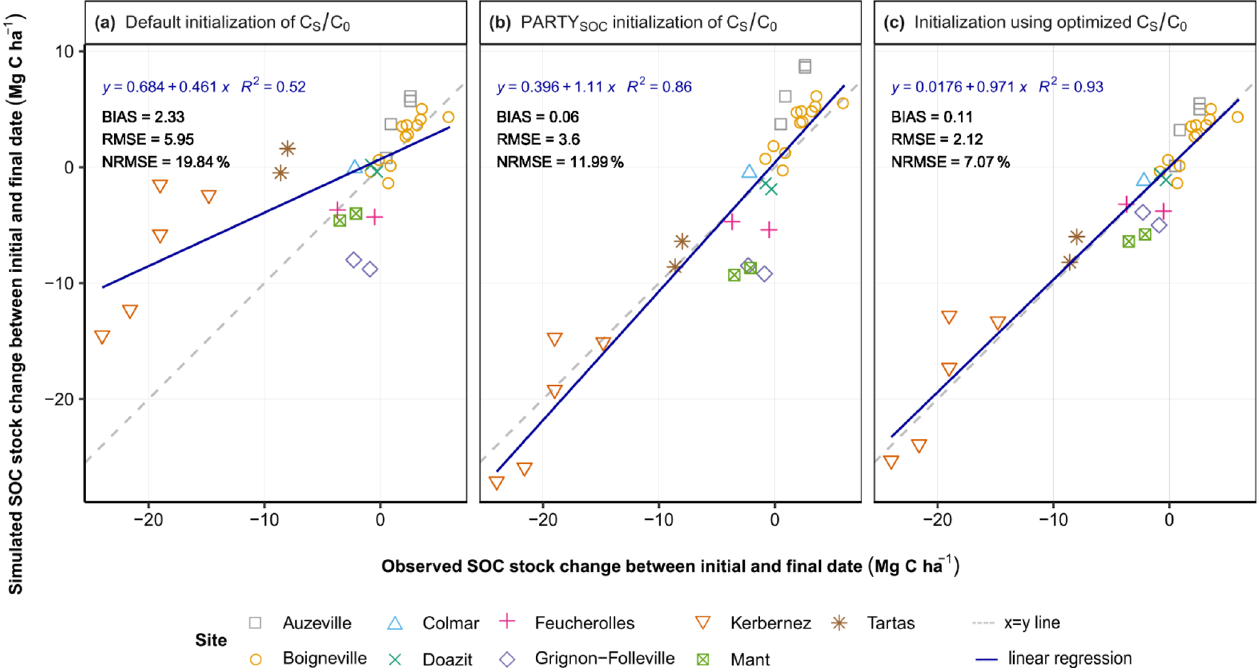
Figure 2. Observed vs. simulated change in SOC stocks between the initial and final date of 32 treatments from nine French long-term experiments. The three panels show the performance of the AMG model for three different initialization approaches. Initial SOC kinetic pool sizes were defined using (a) the default value for cropland (C S / C 0 = 0 . 65), (b) the centennially stable-SOC proportion predicted by the PARTY SOC model, and (c) the ex post AMG-optimized C S / C 0 proportion. Statistics refer to the linear regression between x and y values (blue solid line). Points represent the values for the 32 treatments for which AMG simulations were